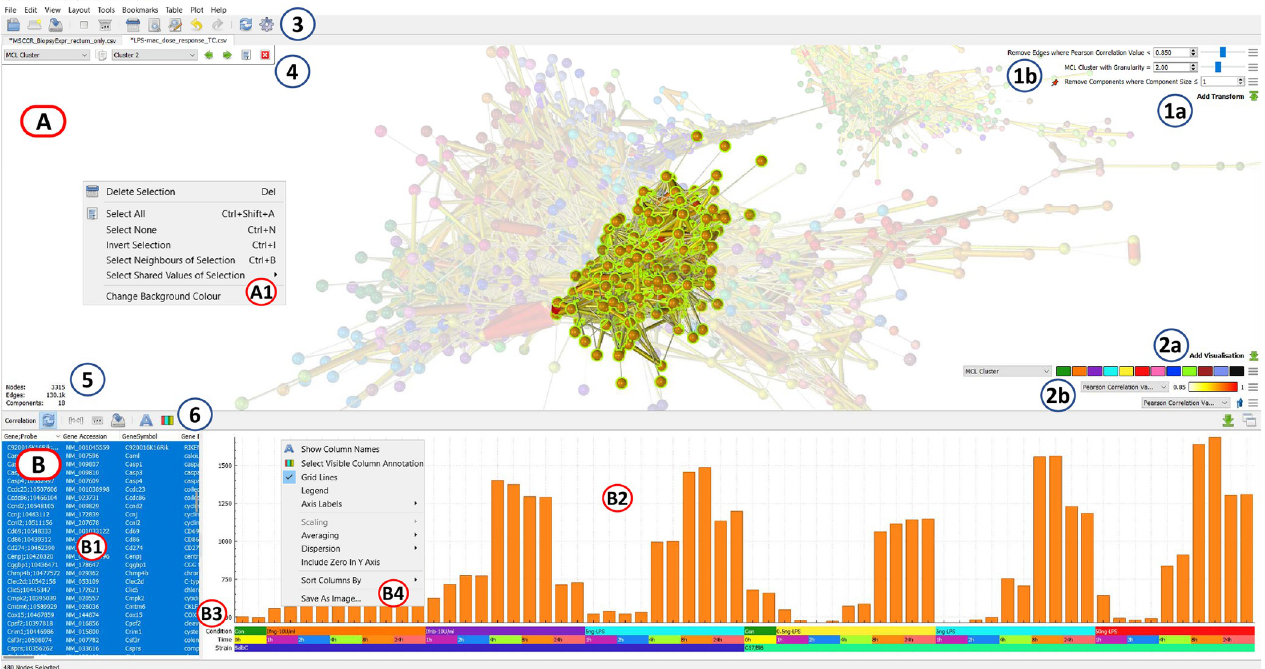
Fig 1. Graphia user interface displaying a correlation graph. (A) Graph display area, showing correlation graph with a cluster selected (unselected nodes faded). (A1) Display context menu options (right click). (B) Node (row) attribute display area. (B1) Table of selected nodes and their attributes, imported and calculated within the tool. (B2) Data plot area, in the case shown here a mean histogram of selected node values. (B3) Visualisation of column annotations. (B4) Data plot context menu options for changing plot (right click). (1a) Add Transform button, (1b) Active transforms, (2a) Add visualisation button, (2b) Active visualisations, (3) General toolbar, (4) Attribute parameter selection, (5) Display of graph metrics (number of nodes, edges, components), (6) Plot/table function toolbar.